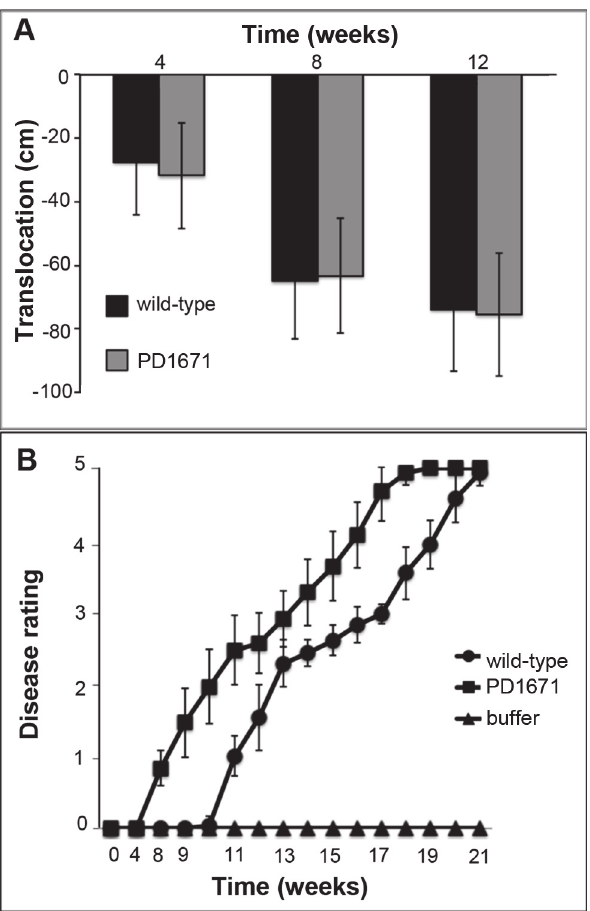
Fig 5. Movement and virulence in grapevines by the X . fastidiosa PD1671 mutant. A ) Basipetal translocation in planta of PD1671 mutant compared to wild-type X . fastidiosa Temecula 1. Average distances at which cells were recovered from vine regions upstream of the inoculation point (represented by 0 on the y axis) after four, eight, and twelve weeks post-inoculation. Error bars represent standard deviation of the means of at least four plants ( P = 0.40). B ) Severity of Pierce's disease. Average of at least 10 plants per treatment with Temecula 1 (circle), PD1671 mutant (square), and buffer negative control buffer (triangle). Experiment was repeated three times. Error bars represent standard deviation of the means of a representative experiment ( P <